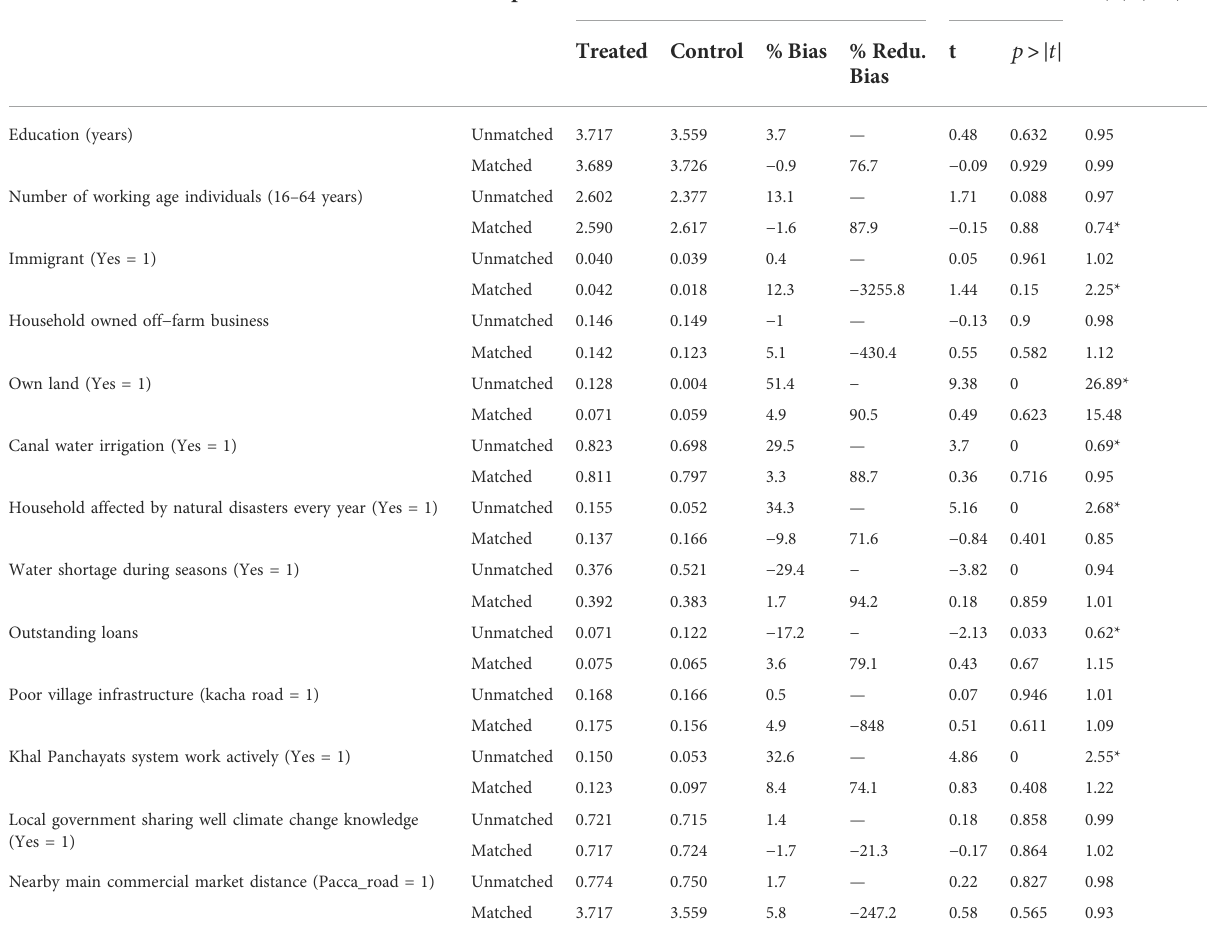
TABLE 9 Results of balancing tests before and after the nearest neighbor 1 − to − 1 matching with replacement (For new entrance into farming). Variable